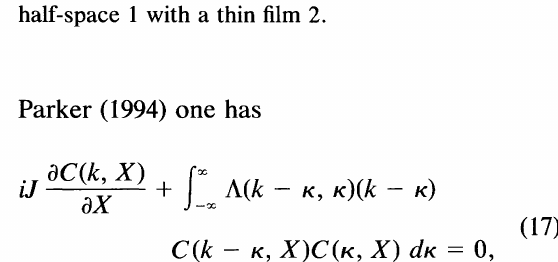
FIGURE 2 Typical problems of surface waves: (a) simple half-space 1; (b) half-space 1 with a layer 2; (c) half-space 1 with a thin film